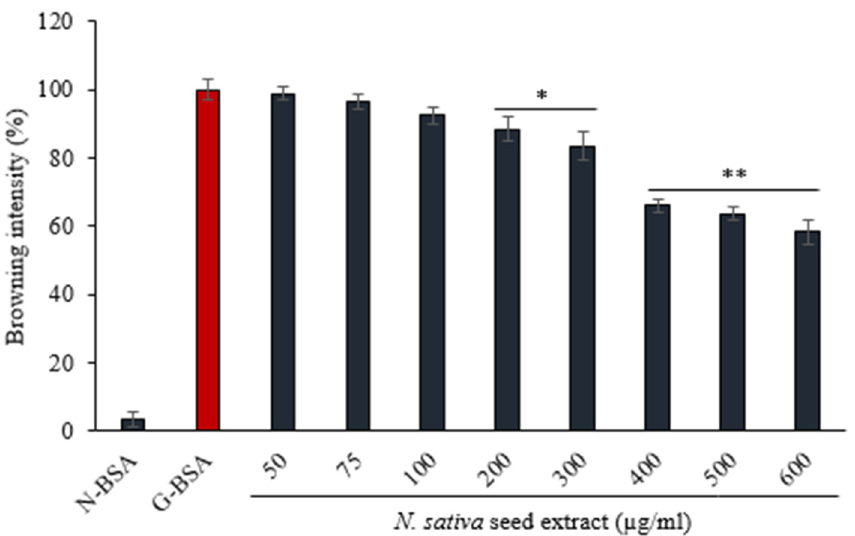
Figure 5. Inhibition of browning of glycated BSA by N. sativa seed extract: Native BSA incubated alone for 15 days. G-BSA: BSA incubated with glucose for 15 days and considered as negative control. The results are presented as means ± SEM ( n = 3). The statistical analysis was performed by using ANOVA (* p ≤ 0.05, ** p ≤ 0.01).